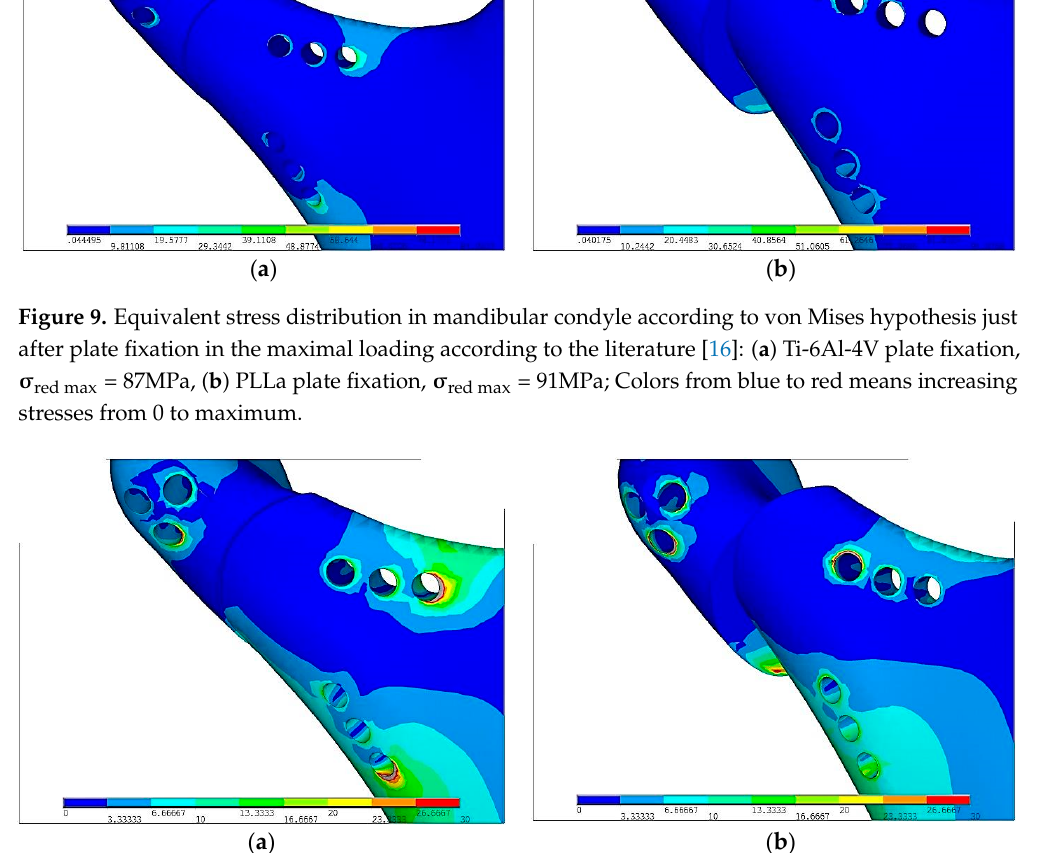
Figure 10. Reduced stress distribution in mandibular condyle according to von Mises hypothesis just after plate fixation in the maximal loading according to the literature [16]: ( a ) Ti-6Al-4V plate fixation, ( b ) PLLA plate fixation; Stresses have been reduced to σ red max = 30